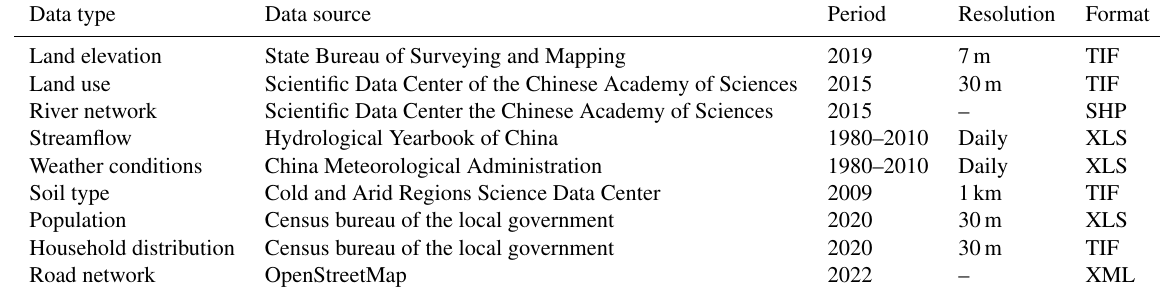
Table 1. List of data used in the integrated model.